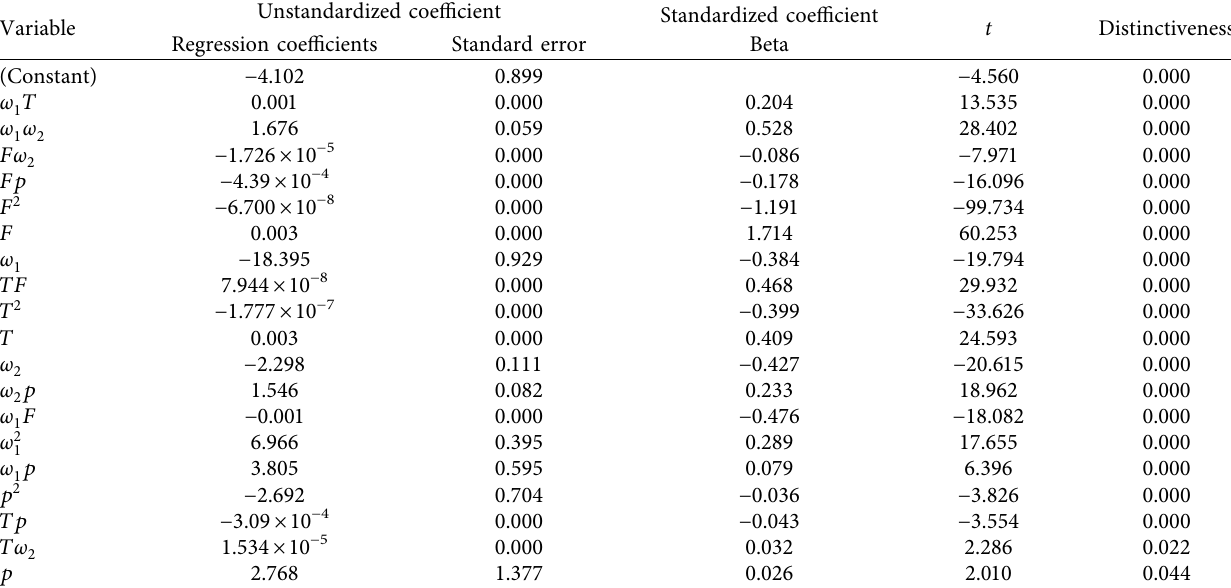
Table 4: Result of multivariate regression parameters of the model.